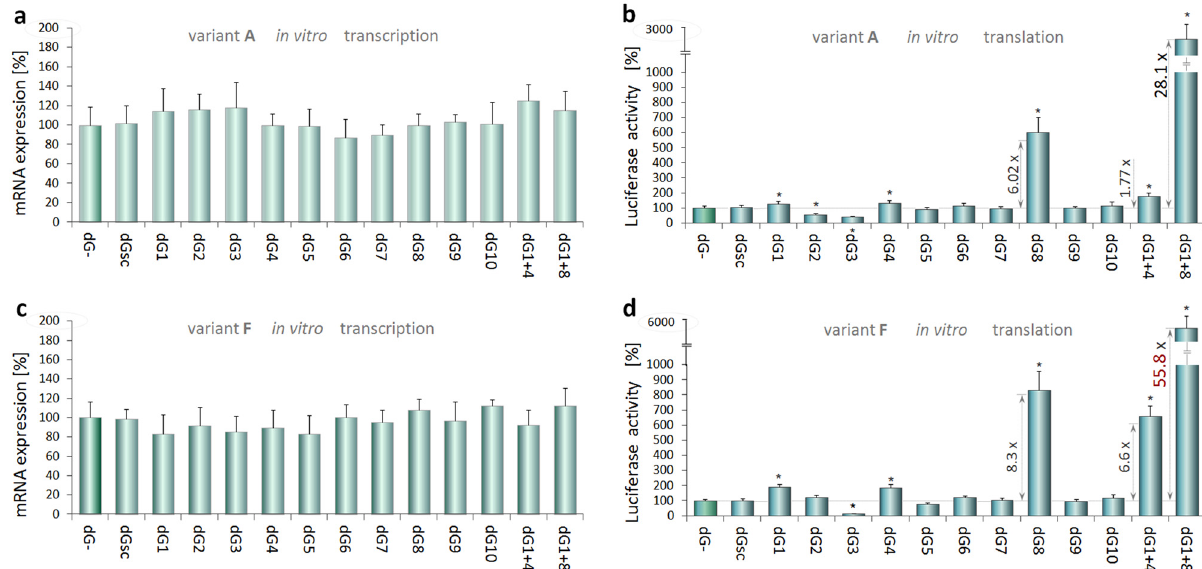
Fig 4. dGoligo-mediated gene expression changes under in vitro conditions. Effects of each DNA oligonucleotides dG1-dG10 (S3 Table), on in vitro transcription of luciferase reporter constructs (panels a , c ) and translation efficiency ( b , d ), using pKS-A (a, b) or pKS-F plasmid (c, d). Data normalized to control (dG-) containing pKS-A or pKS-F without addition of dGoligo. Scrambled control (dGsc) had no effect on transcription or translation. The strongest enhancing effects on luciferase activity were obtained by combining dG1+dG8 (28.10-fold from pKS-A and 55.80-fold from pKS-F). Results from three independent experiments performed in triplicates are shown as mean % mRNA (a, c) or luciferase activity (b, d) ± SD. Data analyzed by ANOVA followed by Dunnett ’ s multiple comparison test. * p < 0.001 vs.